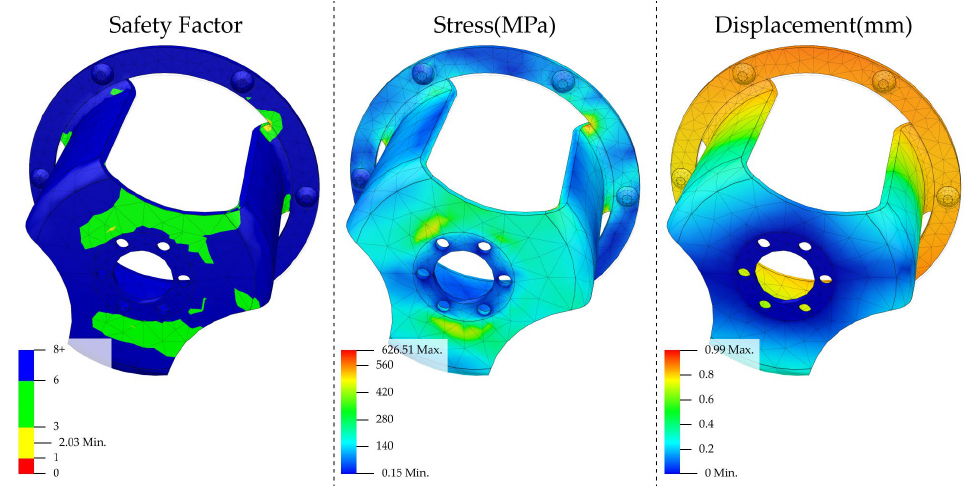
Figure 12. Analysis of condition 2 for hip connector 2. From left to right are safety factor, stress, and displacement.